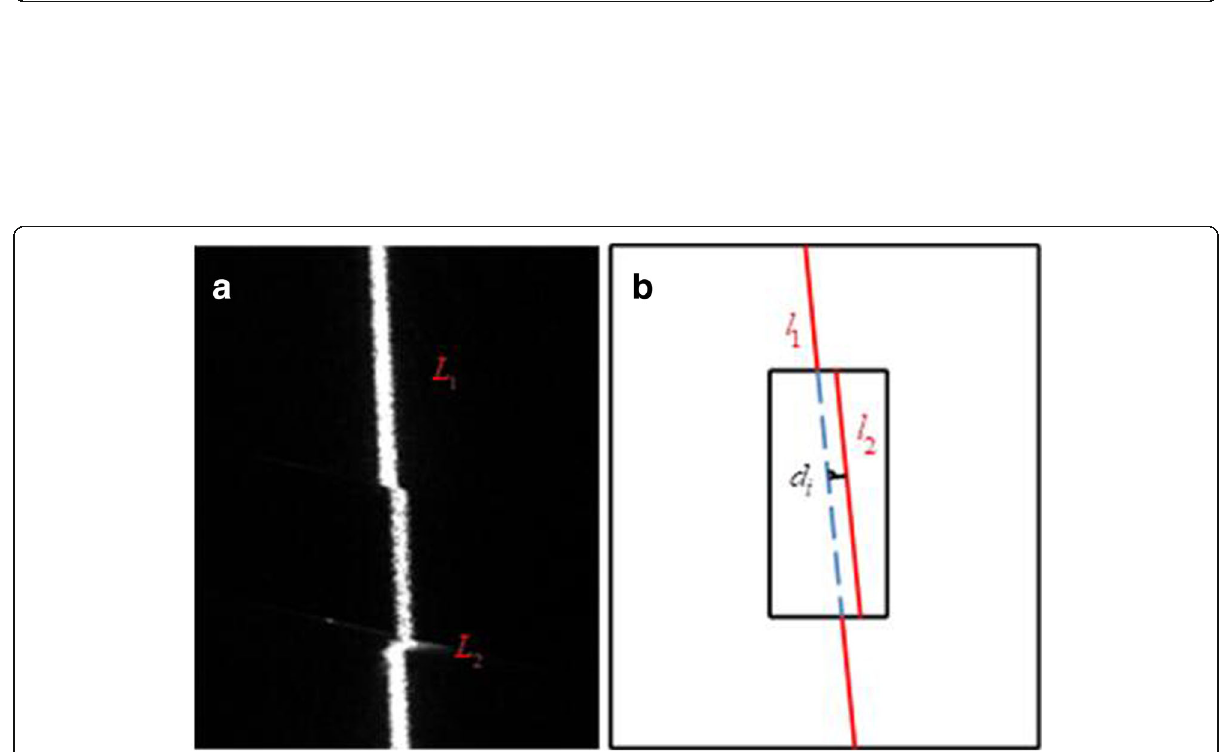
Fig. 11 The light stripe on the target and on the block. a Light stripes on the target and on the block b The schematic diagram of the